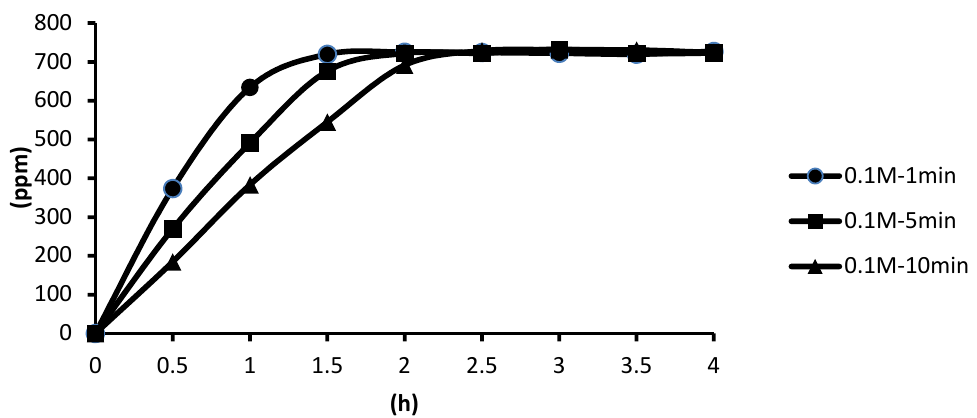
Figure 12. The effect of cross-linking time by 0.1 M CaCl 2 on releasing of tea tree essential oil from alginate/tea tree essential oil microcapsules in the hot spring water.